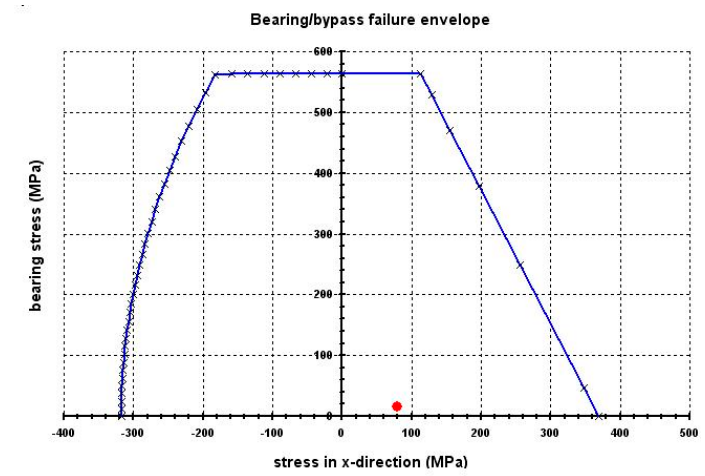
Figure 7. Bearing bypass failure envelope.